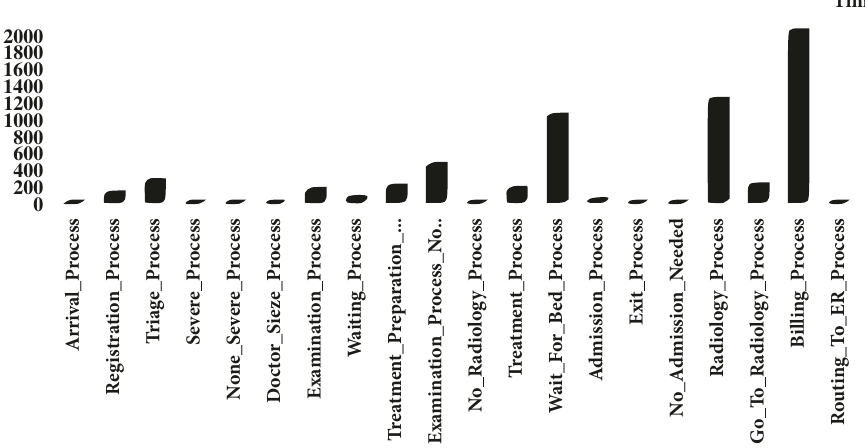
Figure 5: Units service time.